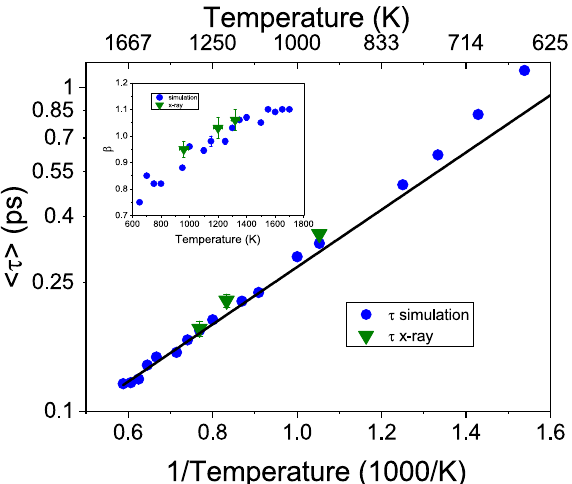
Figure 3. The relaxation times < τ > from the KWW-fits to the simulation and X-ray data are plotted against the inverse temperature on a logarithmic scale. The inset shows the resulting stretching parameter β . The line is a linear fit through the high temperature points ( T > 1400 K ) in this Arrhenius-type plot.